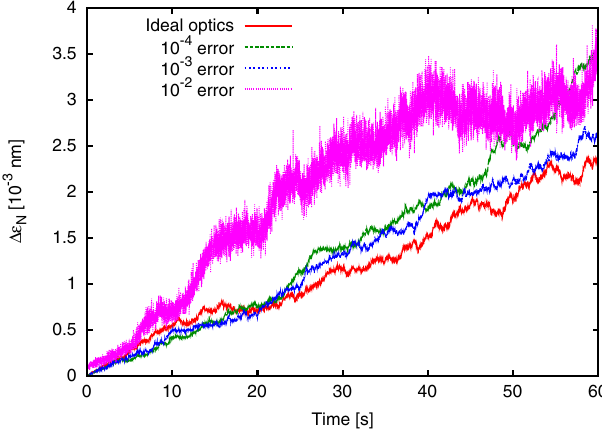
FIG. 13. (Color) Emittance growth vs time for a basic feedback system using 1324 BPMs and 80 correctors. The feedback performance is seen not to be strongly affected by imperfect knowledge of the machine optics.